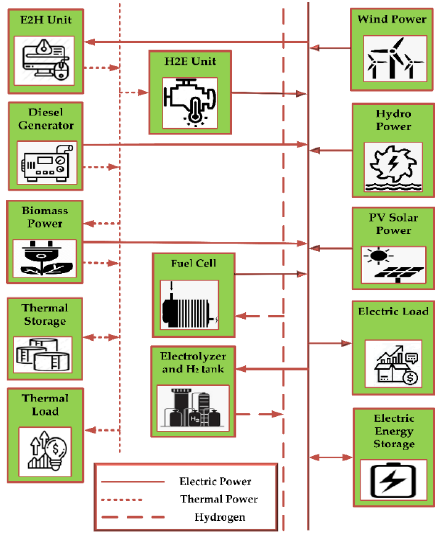
Figure 1. System architecture of a diesel-based MEG.